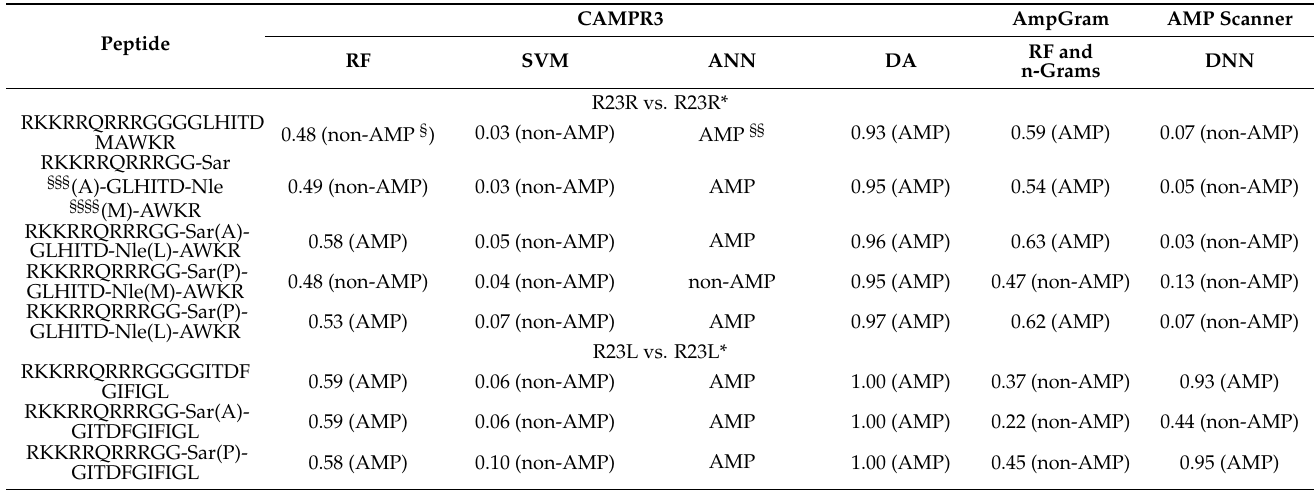
Table 2. Antimicrobial prediction for the R23R, R23L, R23L*, and R23L* peptides.